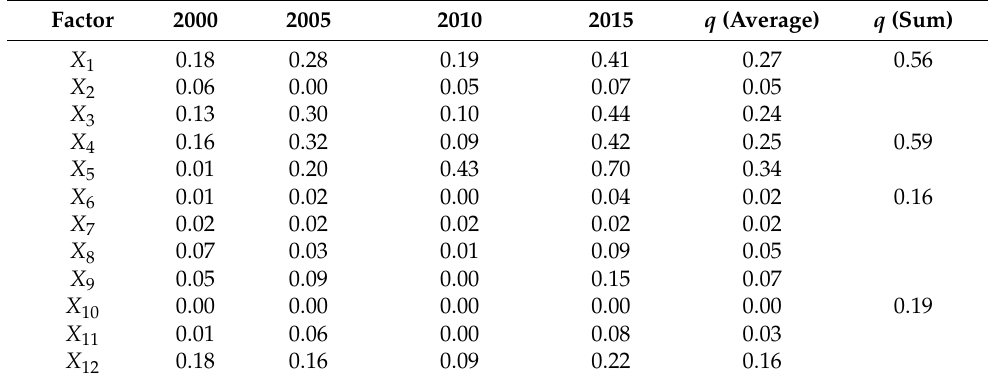
Table 3. Factor detection results of drought differences in the Yangtze River